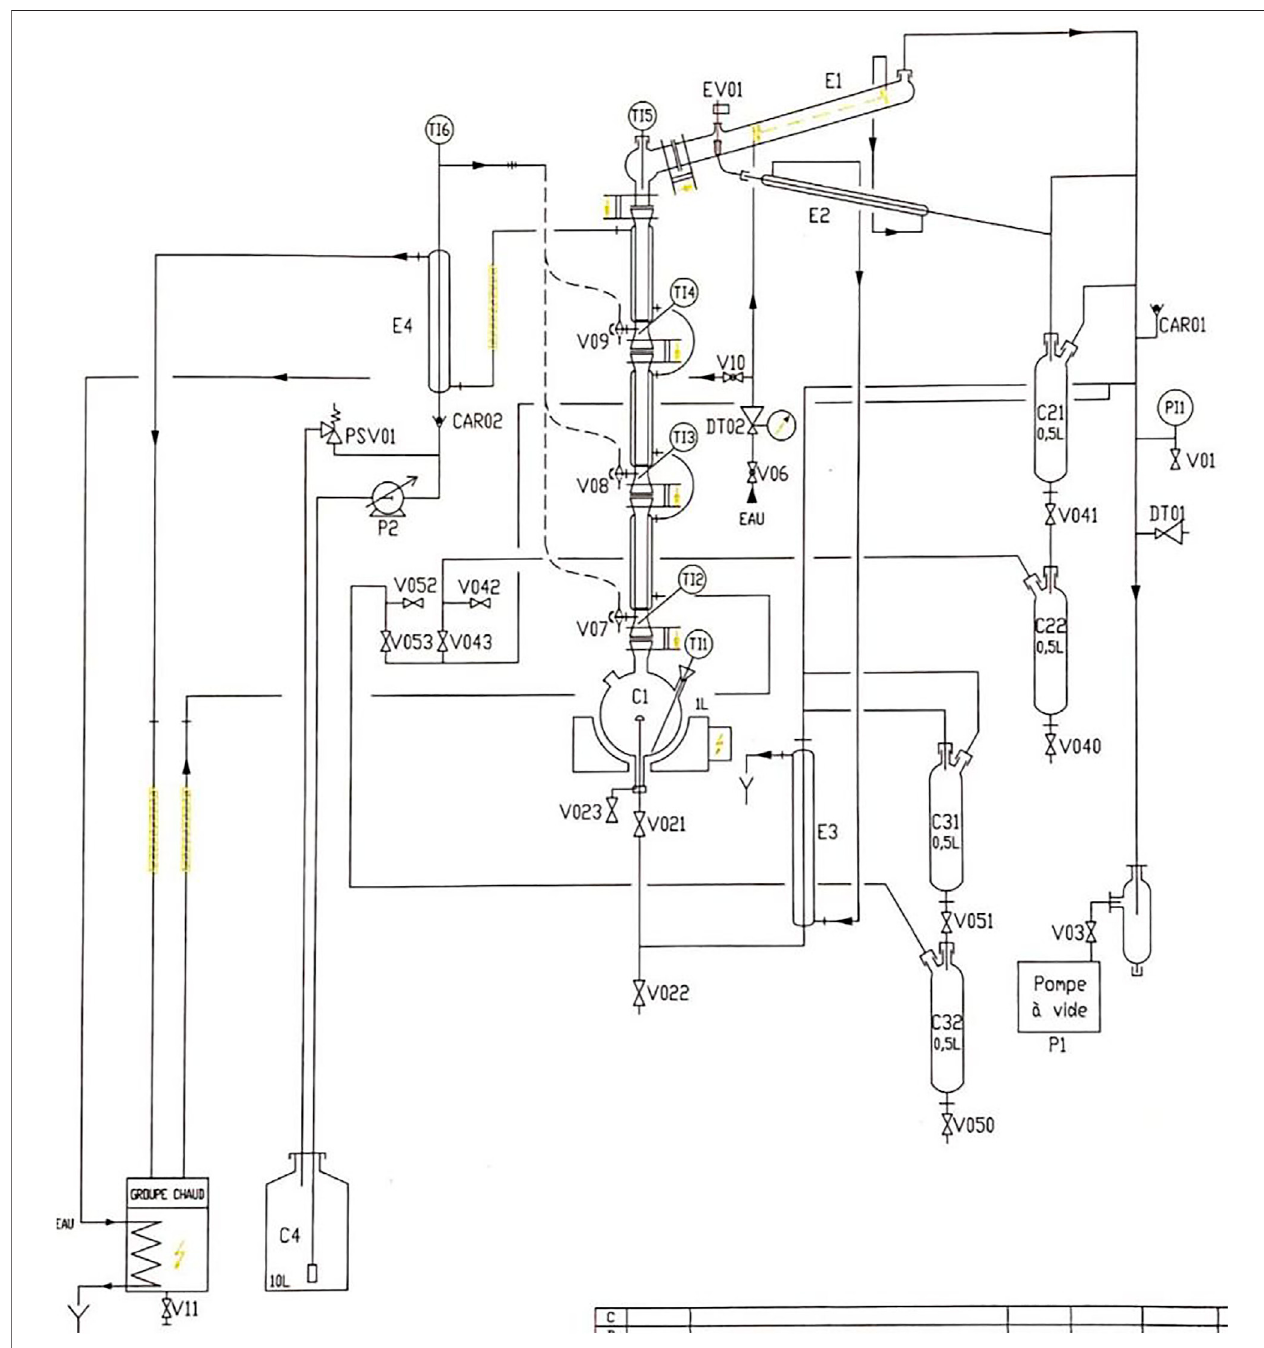
FIGURE 2 | Reactive distillation pilot design by PIGNAT ®